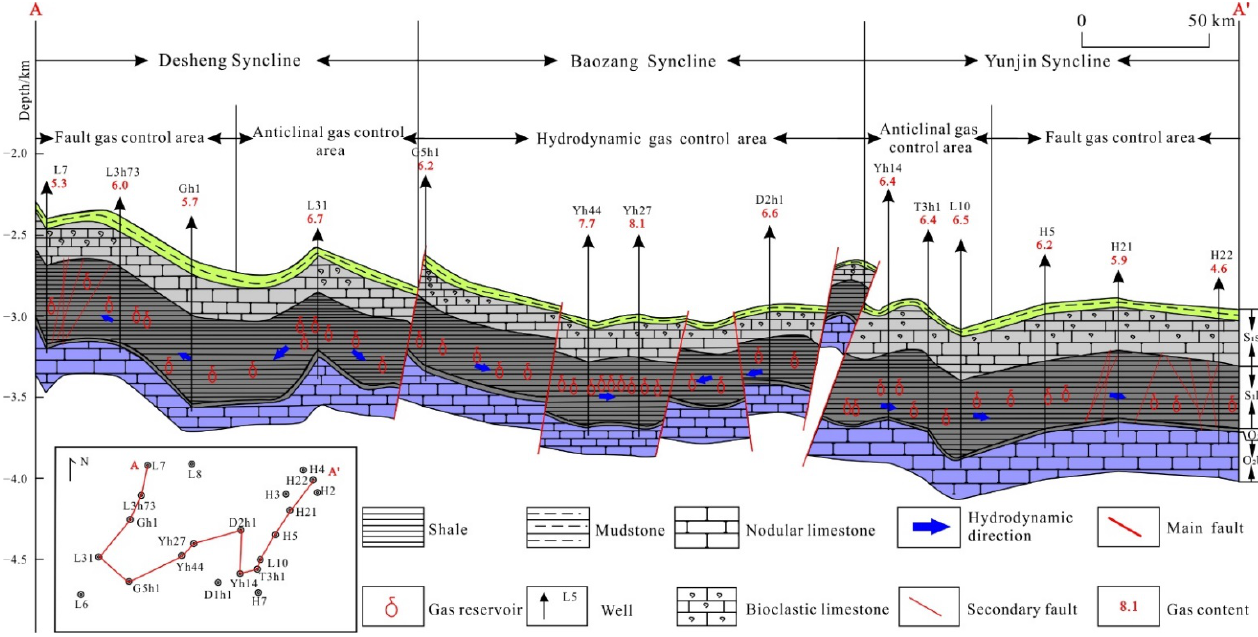
Figure 10. Shale gas enrichment pattern of the Longmaxi Formation in the Desheng–Yunjin Syn- cline area.